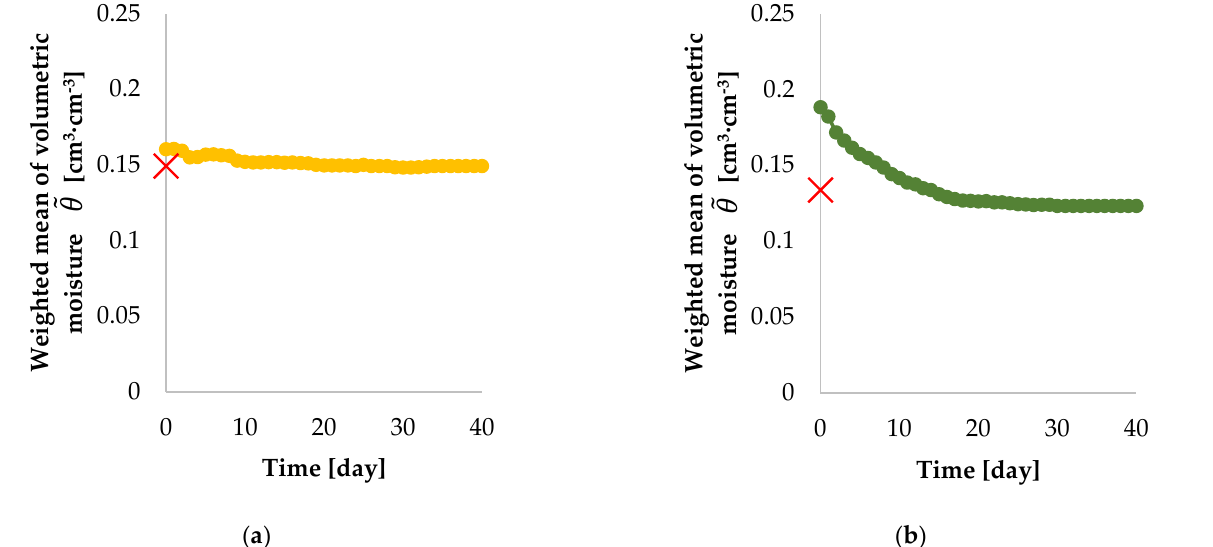
Figure 8. Dynamics of volumetric moisture of soil after the injection of 250 ( a ) and 1000 ( b ) cm 3 of water at the depth of 10 cm.